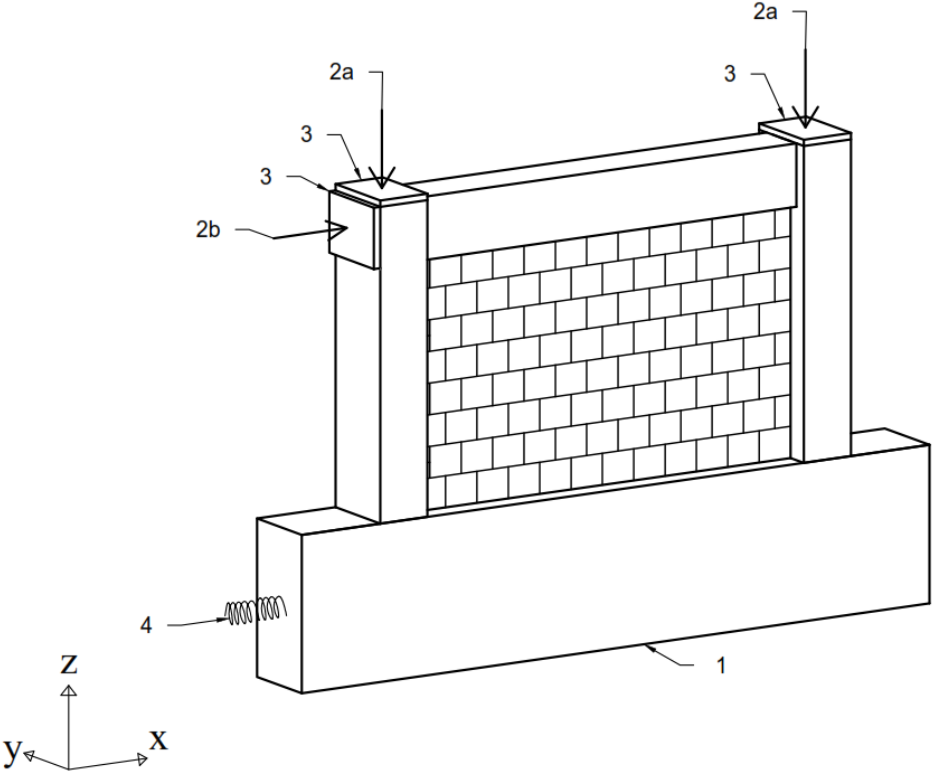
Figure 4. Boundary condition of meso-model-ATENA